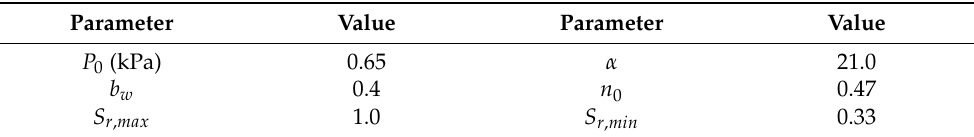
Figure 5. ( a ) The calibrated Water Retention Model (WRM) (laboratory data from [24]); ( b ) the Water Retention Curve (WRC) used in the analyses with the corresponding evolution of the s · S r term. Table 1. Ruedlingen WRM parameters used in this study.